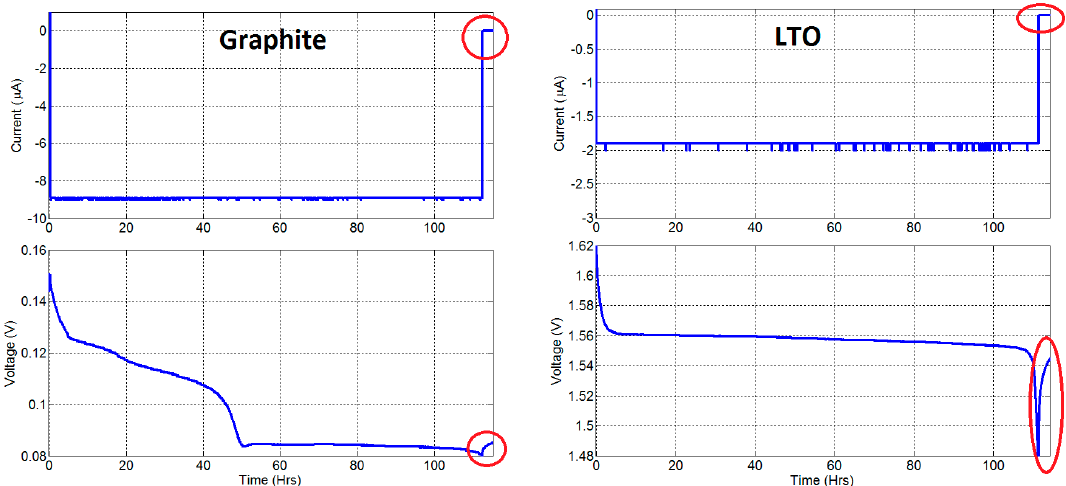
Figure A2. Terminal voltage curves of discharges at a very small current rate.